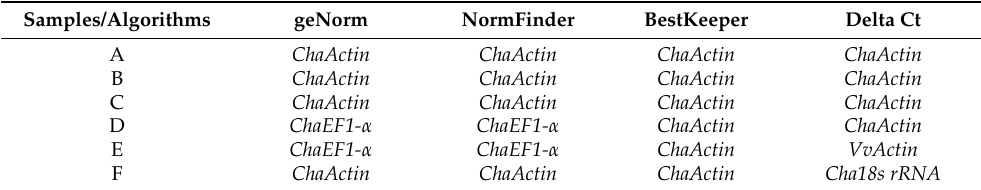
Table 8. The most suitable reference gene for each group of samples selected from different soft- ware packages.